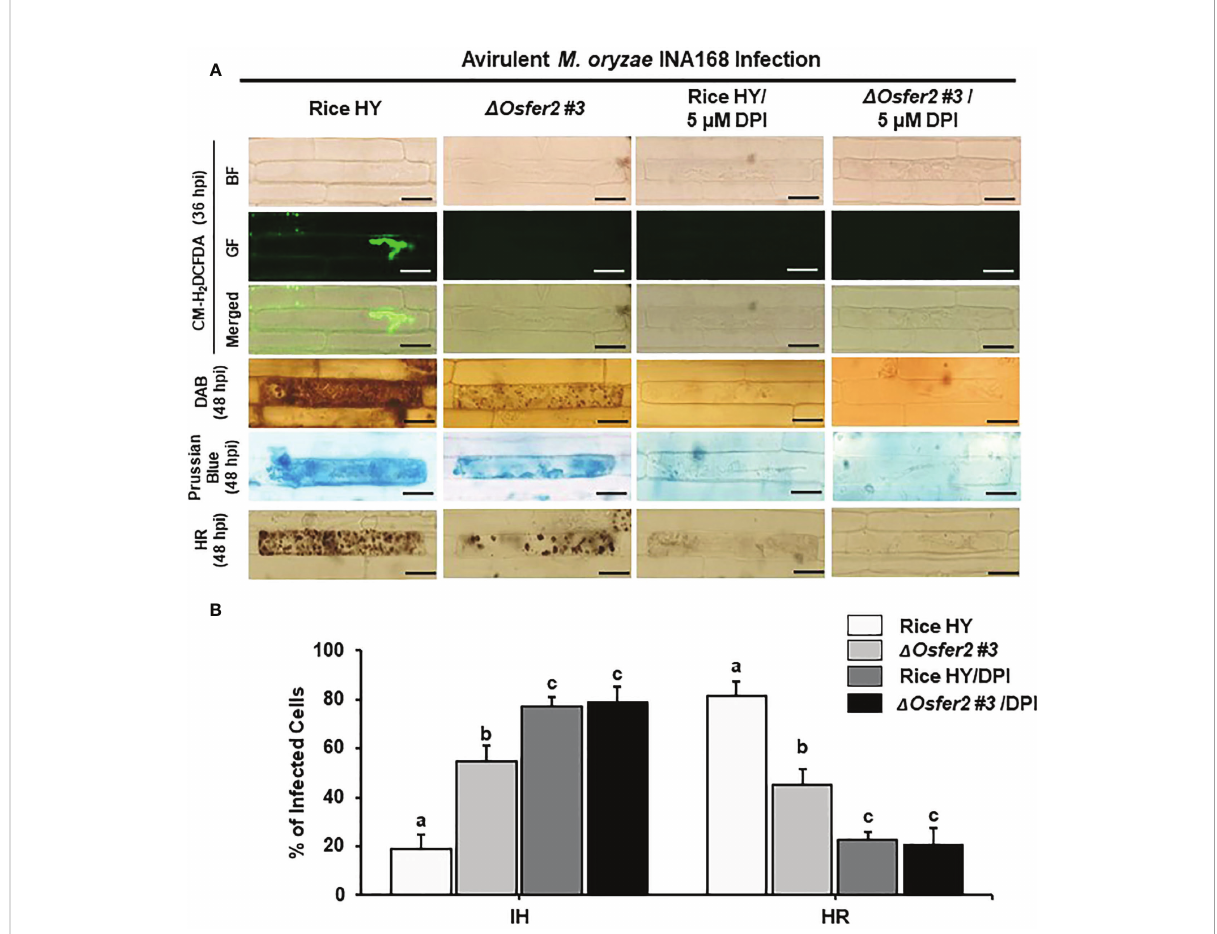
FIGURE 12 Treatment with the redox inhibitor diphenyleneiodonium (DPI) inhibits ROS and ferroptotic HR cell death in the rice sheath epidermal layers of rice HY and D Osfer2 knock-out mutants infected with avirulent Magnaporthe oryzae INA168. (A) Microscopic images of HR cell death, DAB, Prussian blue and CM-H 2 DCFDA staining of rice sheath epidermal cells infected with M. oryzae INA168 and treated with DPI (5 µM). Scale bar = 20 µm. (B) Quanti fi cation of invasive hyphae (IH) and hypersensitive response cell death (HR) in rice sheath cells infected with M. oryzae INA168 and treated with DPI. DPI was treated with M. oryzae conidia (4×10 5 conidia mL − 1 ) to the rice leaf sheaths, followed by 48 h-incubation at 25°C in dark condition. The values are means ± SD; n=4 leaf sheaths from different plants. Different letters above the bars indicate signi fi cantly different means (P<0.05), as analyzed by one-way ANOVA analysis. hpi, hour post-inoculation; HR, hypersensitive response; BF, bright fi eld; GF, green fl